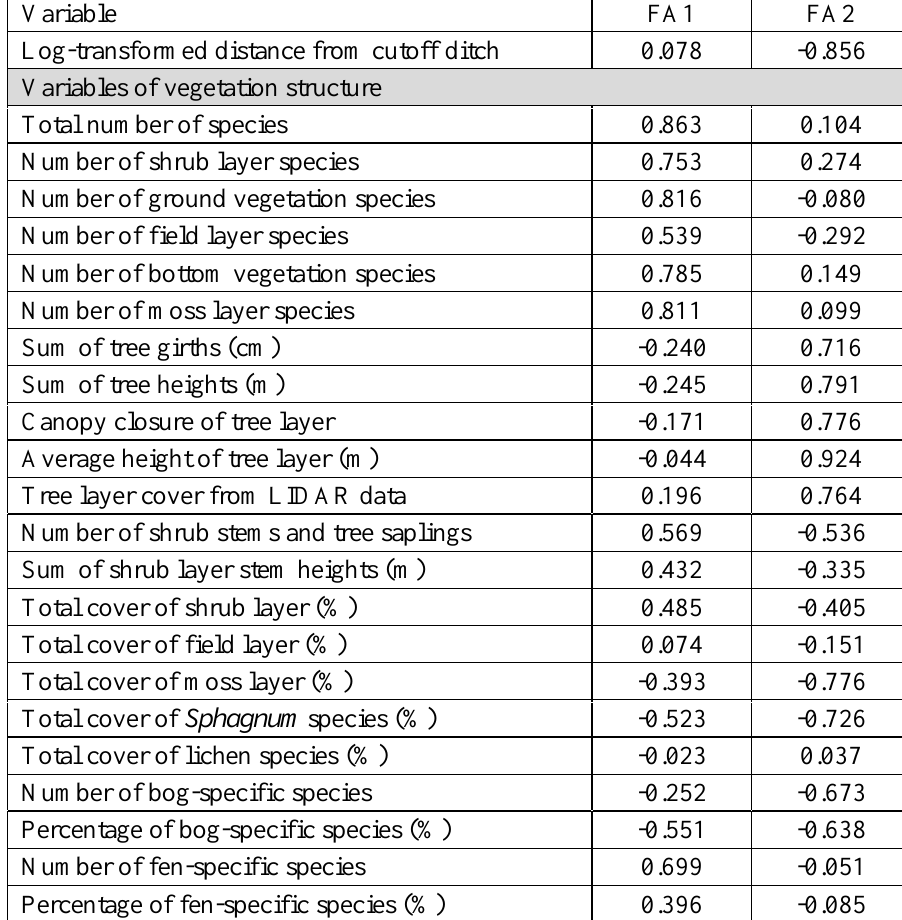
Table 1. Factor loadings of vegetation structural characteristics and habitat environmental variables by first two factors (FA1, FA2) of the factor